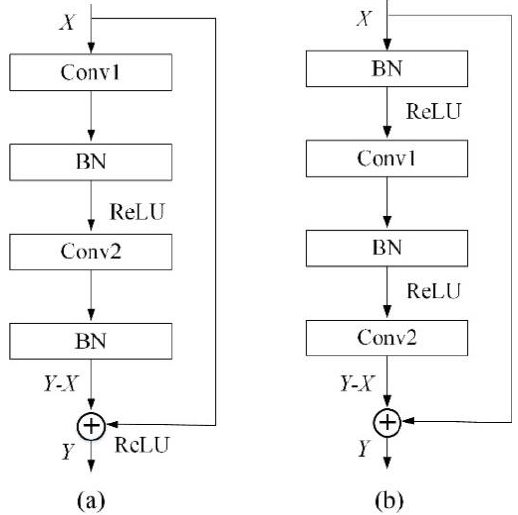
Figure 4. The residual structure of the block diagram: ( a ) Indentity residual block; ( b ) Sampling residual block.